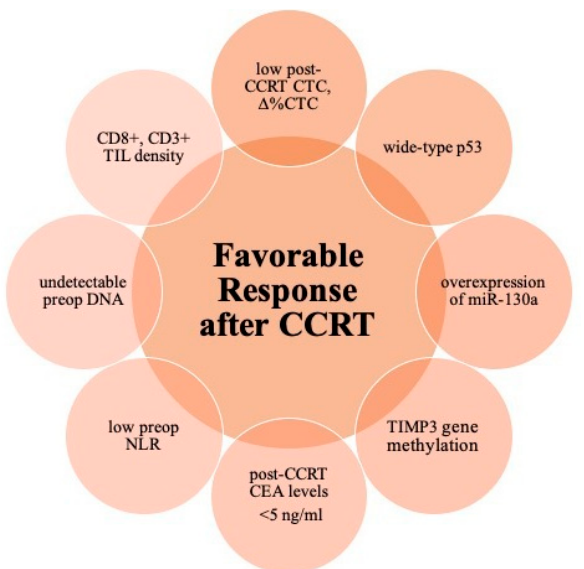
Figure 1. Schematic diagram of favorable biomarkers for neoadjuvant concurrent chemoradiation in patients with locally advanced rectal cancer. Abbreviations: CCRT, concurrent chemoradiation; CTC, circulating tumor cells; CEA, carcinoembryonic antigen; NLR, Neutrophil-to-lymphocyte ratio; preop, preoperative; TIL, tumor-infiltrating lymphocytes. 7. Patient-Derived Xenograft (PDX) and In Vitro Tumor Organoid (PDO) Successful disease-specific preclinical models are still absent. Guenot et al. reported